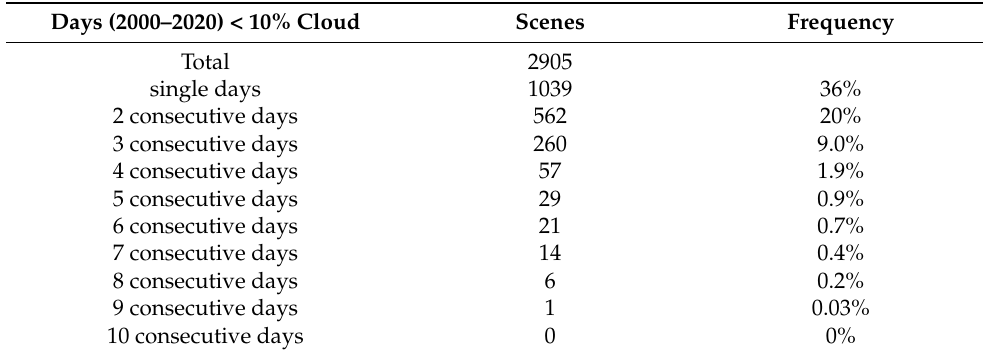
Table 2. Availability of cloud-free (<10%) MODIS data (2905 scenes) acquired over the study area and period (2000 −